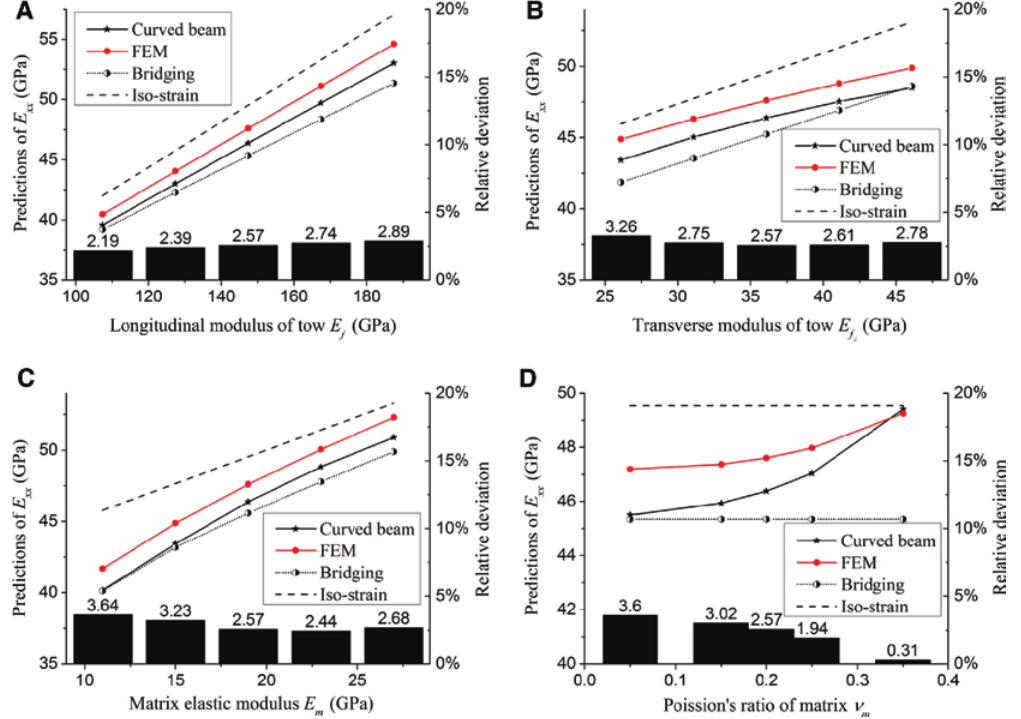
(lines with left axis) and relative deviation of curved beam model (column bars with right axis) from different Figure 16: The predicted E xx models with variant constitutive